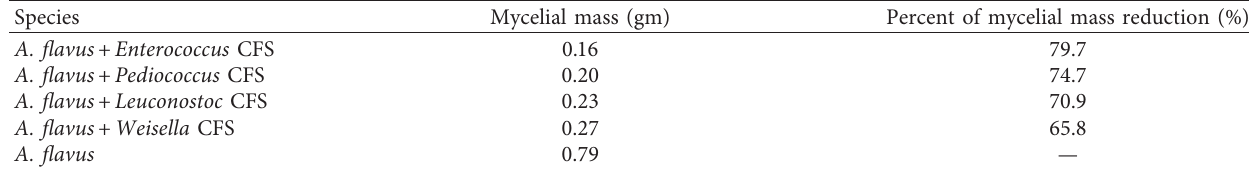
Table 10: Effect of LABCFS on the concentration of AFB